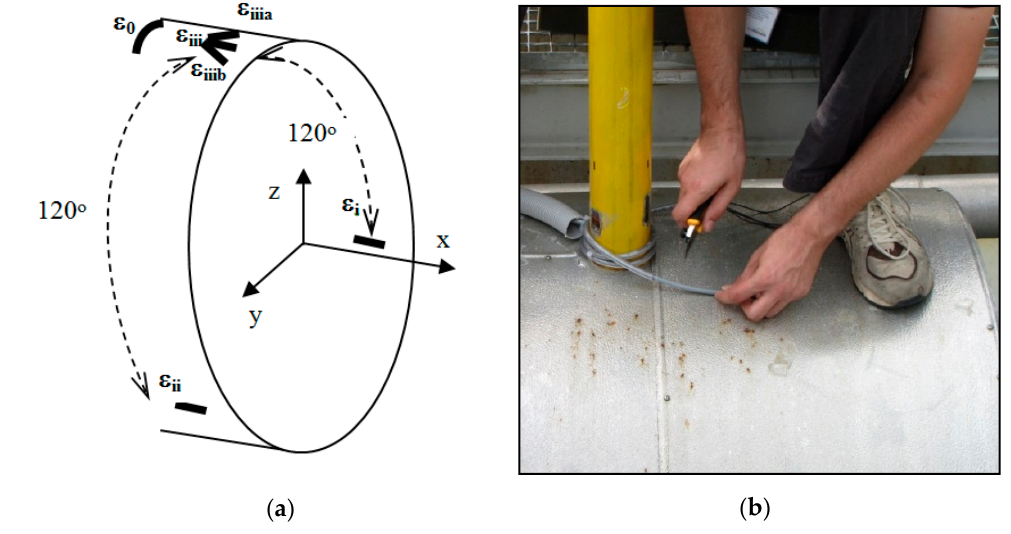
Figure 3. Frequency composition of signals measured by accelerometers and strain gauges on the vibrating pipe branch.